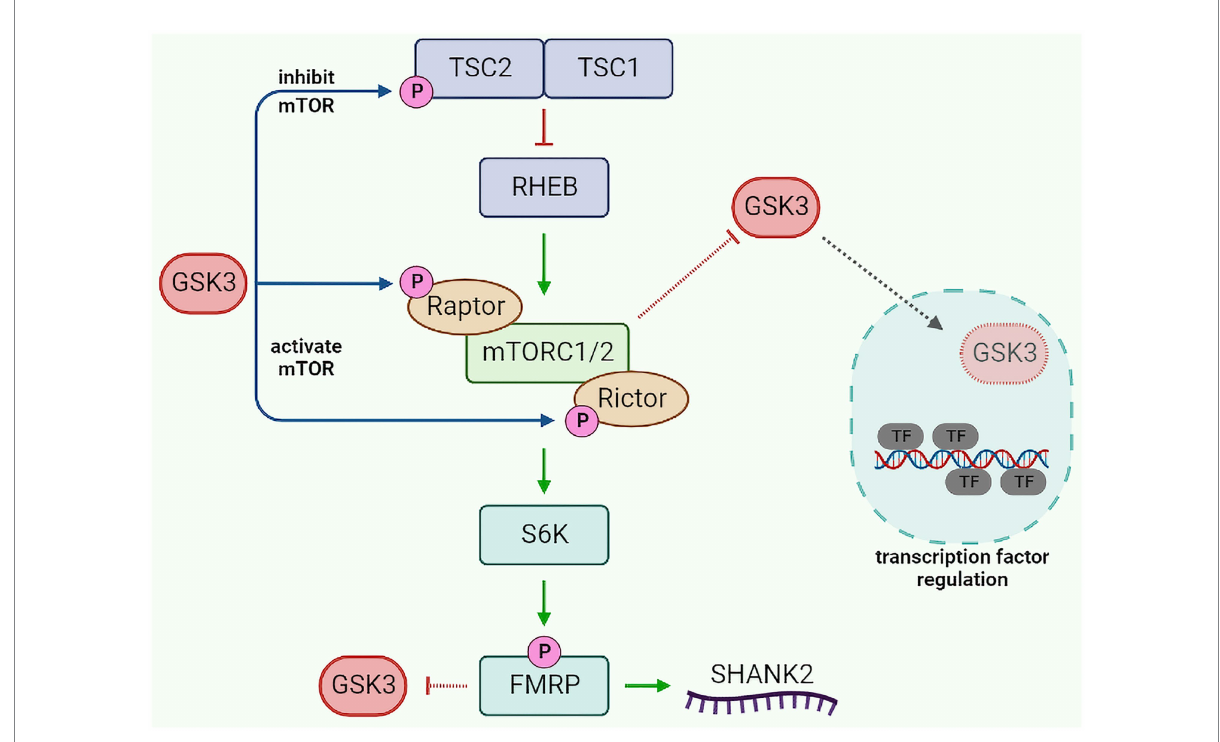
FIGURE 2 GSK3-mTOR-FMRP pathway crosstalk. GSK3 modulates mTOR activity by phosphorylating TSC2 (inhibit mTOR) or Raptor/Rictor (activate mTOR). Activated mTOR can inhibit GSK3 translocation to the nucleus, resulting in decreased GSK3-dependent regulation of transcription factors. Additionally, mTOR can increase FMRP activity ( via S6K), which in turn can inhibit GSK3 and regulate SHANK2. GSK3, glycogen synthase kinase 3; TSC1/2, tuberous sclerosis 1/2; RHEB, ras homolog enriched in brain; mTORC1/2, mechanistic target of rapamycin complex 1/2; S6K, S6 kinase; FMRP, fragile X messenger ribonucleoprotein 1; SHANK2, SH3 and multiple ankyrin repeat domains protein 2; and TF, transcription